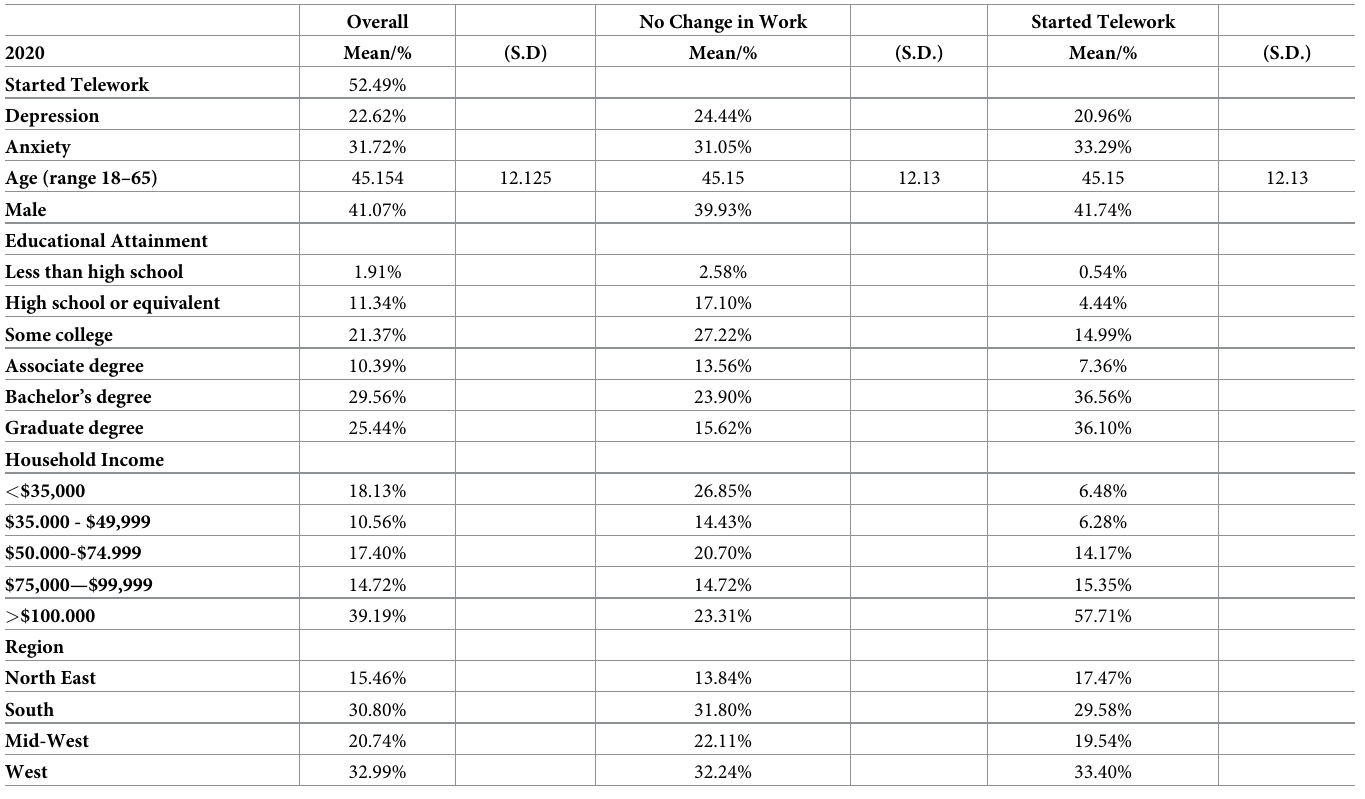
Table 1. 2020 household pulse survey data. Overall No Change in Work Started